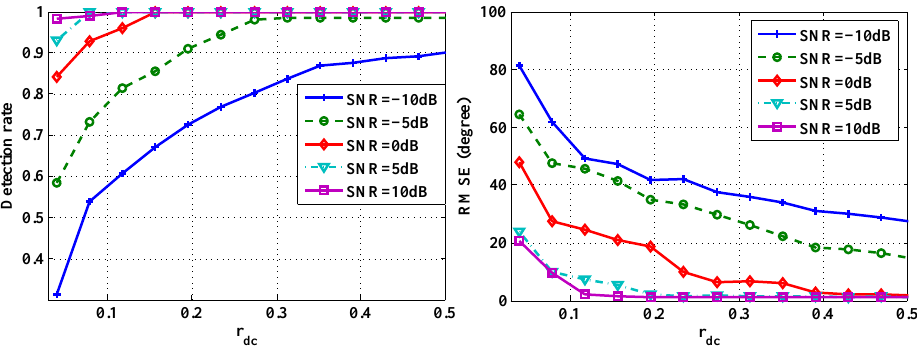
Figure 4. Performance comparison of the CSJSR-DoA approach under different data volumes: ( left ) detection rate ( right )